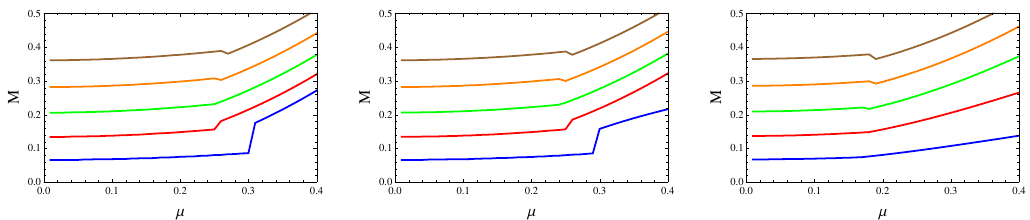
Figure 10 . The magnetisation M as a function of the chemical potential (cid:22) for (cid:12)ve di(cid:11)erent values of the magnetic (cid:12)eld b = 0 : 05 (blue), b = 0 : 1 (red), b = 0 : 15 (green), b = 0 : 2 (orange) and b = 0 : 25 (brown). The left, center and right panels correspond to v T = 0, v T = 0 : 1 and v T = 0 : 3 respectively.